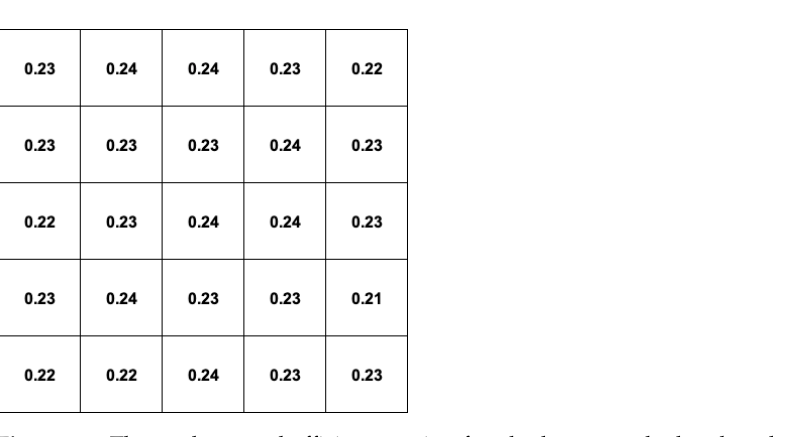
Figure 12. The count rates of the 5 × 5 array under the peak at 511 keV. Left: without the collimator; right: with the collimator.